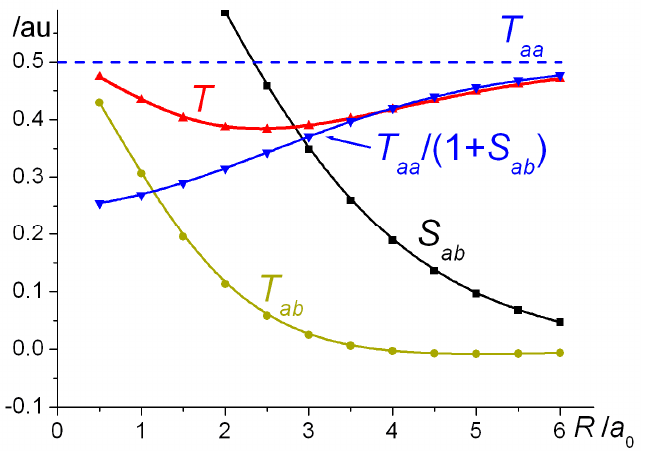
Figure 3. H 2 + ( ζ = 1): Bond length dependence of the overlap S ab , kinetic energy matrix elements T aa and T ab and the contribution T aa / (1 + S ab ) to the total kinetic energy T .